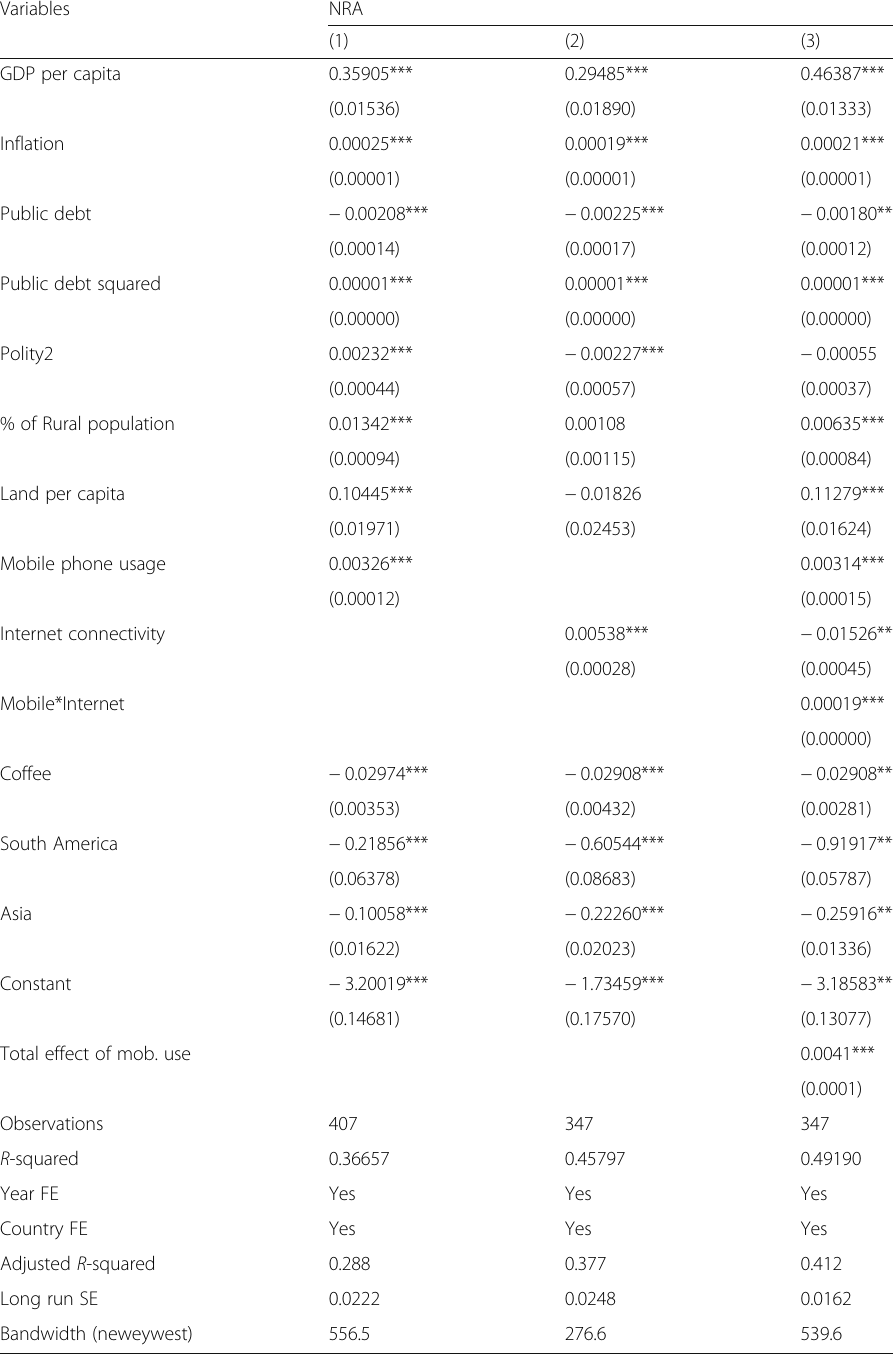
Table 3 Testing stylized facts of total NRA